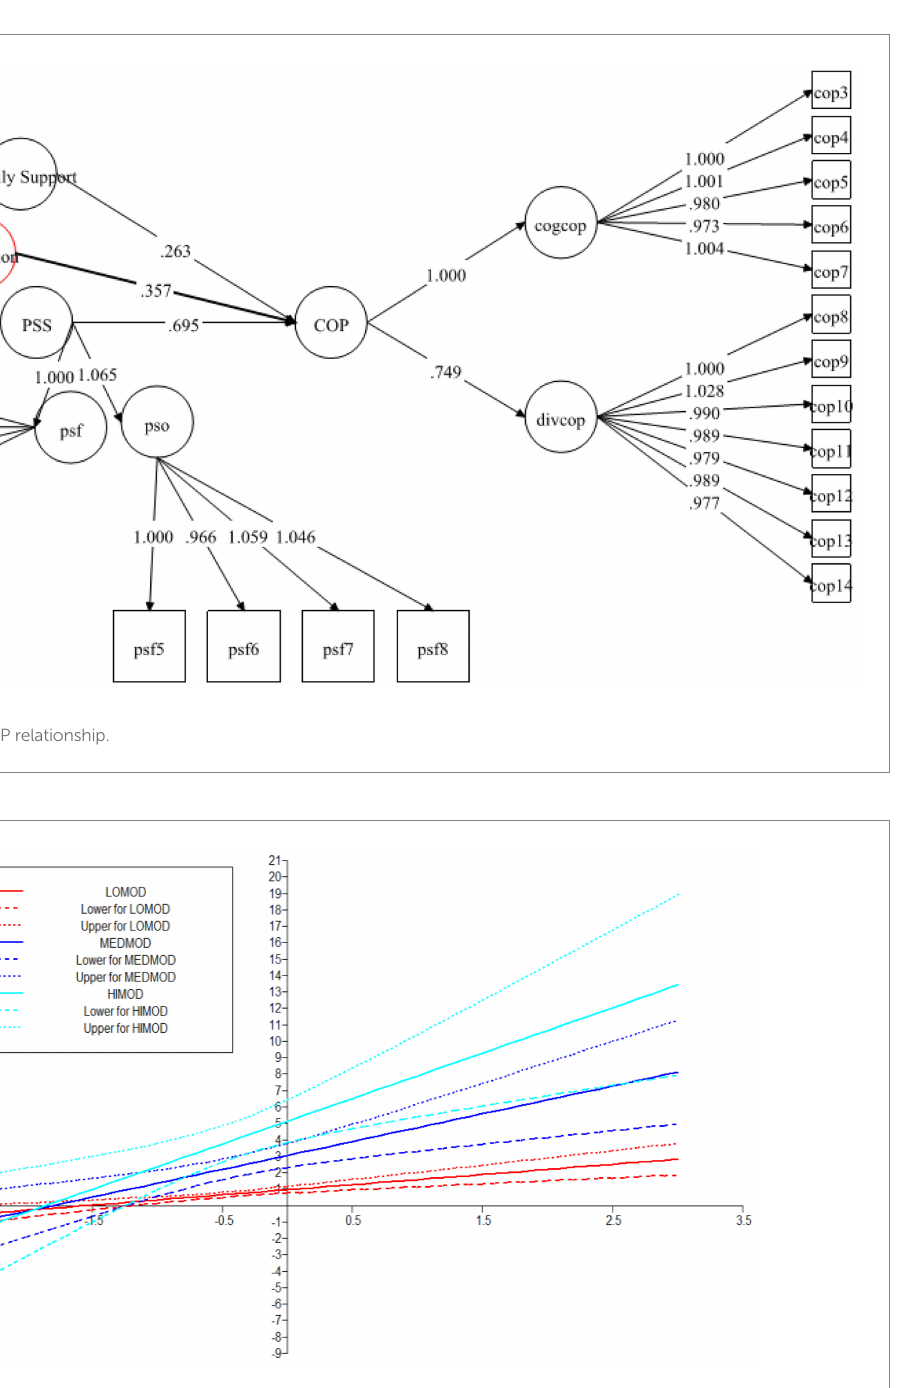
FIGURE 9 Interaction platt showing the moderating effect of PSS on FS—COP